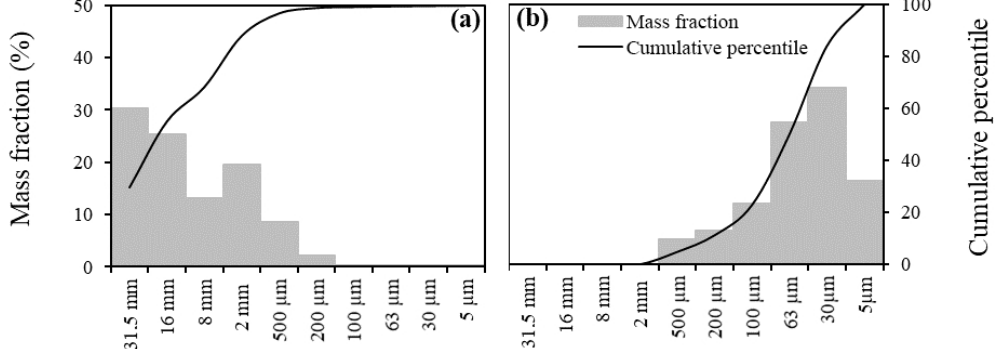
Figure 4. Sediment grain-size distributions estimated from the Orne river sediment samples collected in (a) the riverbed and (b) the riverbanks (average value over nine samples collected at three different river